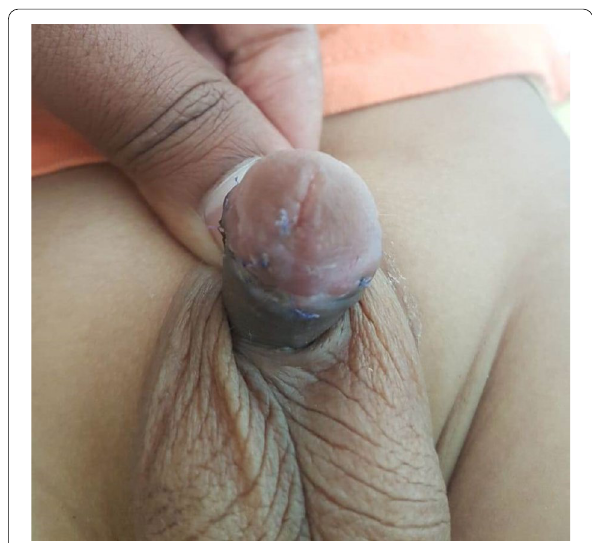
Fig. 7 Final results. Note the conical glans and normal appearance of